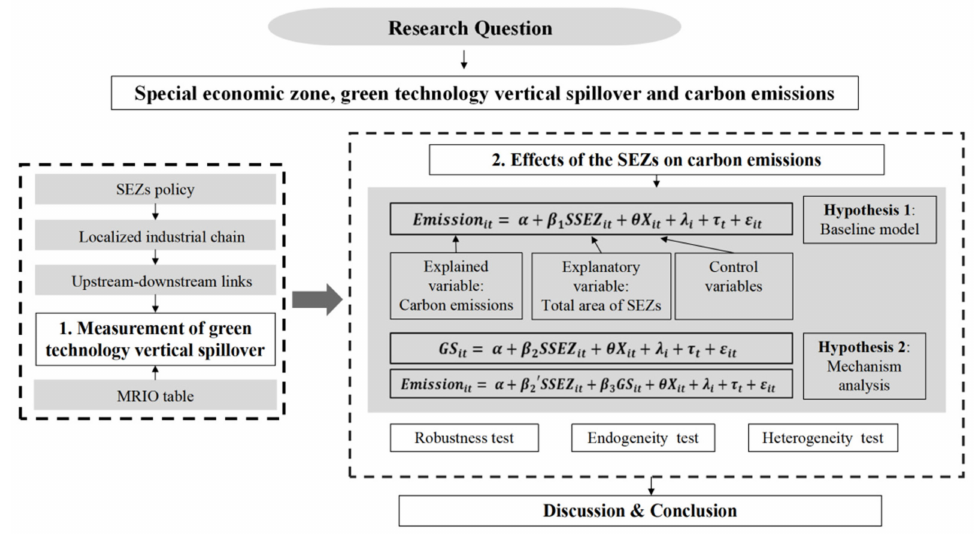
Figure 1. Research framework (Source: Own